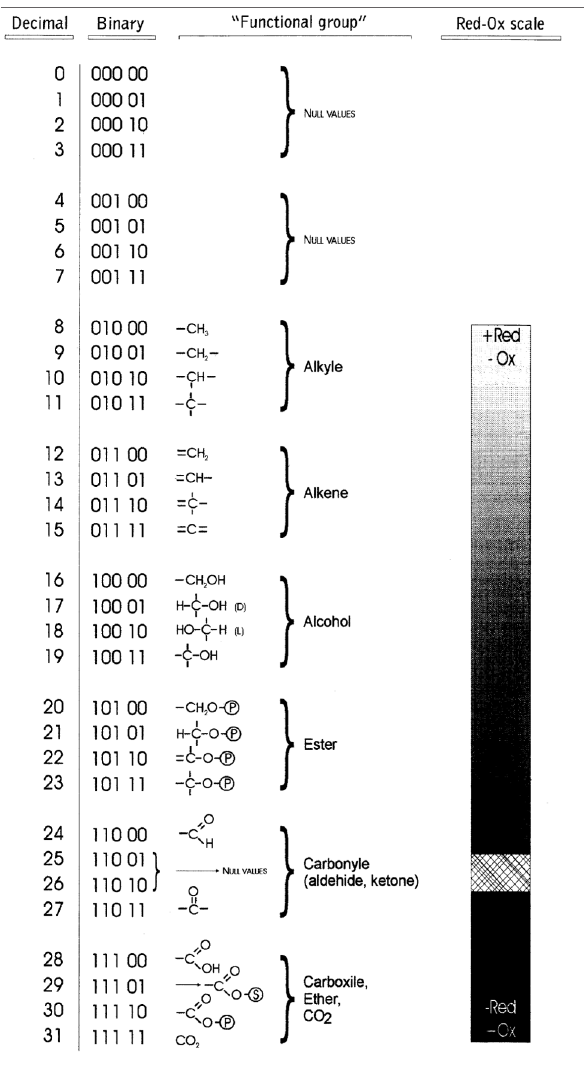
Table 1 | Rosetta stone for the hardware implementation of metabolic pathways.